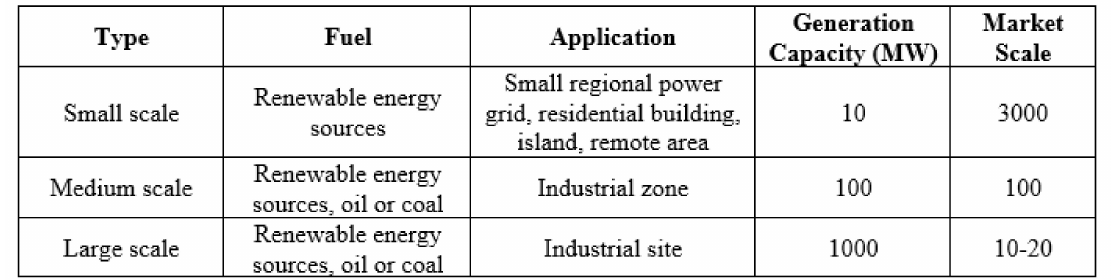
Figure 10. Classifications of micro-grids by Mitsubishi